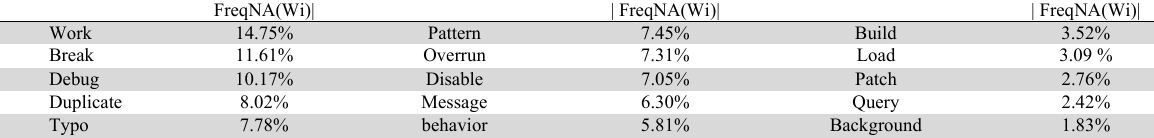
Top 15 Words With Probability Close To 0 Ordered By Occurrence Frequency In Corpus_Na For The Koffice System.